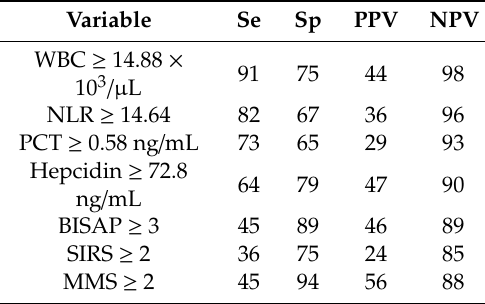
Table 3. Prognostic accuracy of the biochemical markers and the score systems of acute biliary pancreatitis severity on admission.